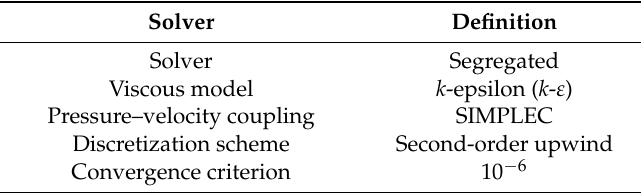
Table 2. Solver parameter